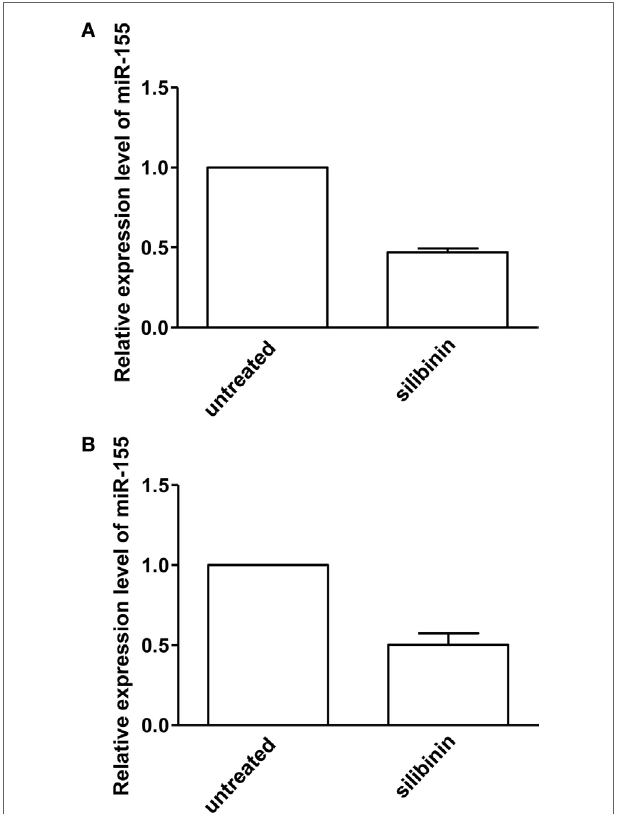
FigUre 7 | Quantitative real-time PCR (qRT-PCR) analysis of microRNA-155 (miR-155) expression level in peripheral blood T lymphocytes from rheumatoid arthritis (RA) patients. qRT-PCR analysis of miR-155-3p expression level in T lymphocytes isolated from five female (a) and two male (b) RA patients, treated or not with silibinin for 48 h. The values of fold change were calculated by the 2 −ΔΔ Ct method relative to untreated RA patient. The mean ± SD values, referred to the fold of change between treated and untreated patients, were